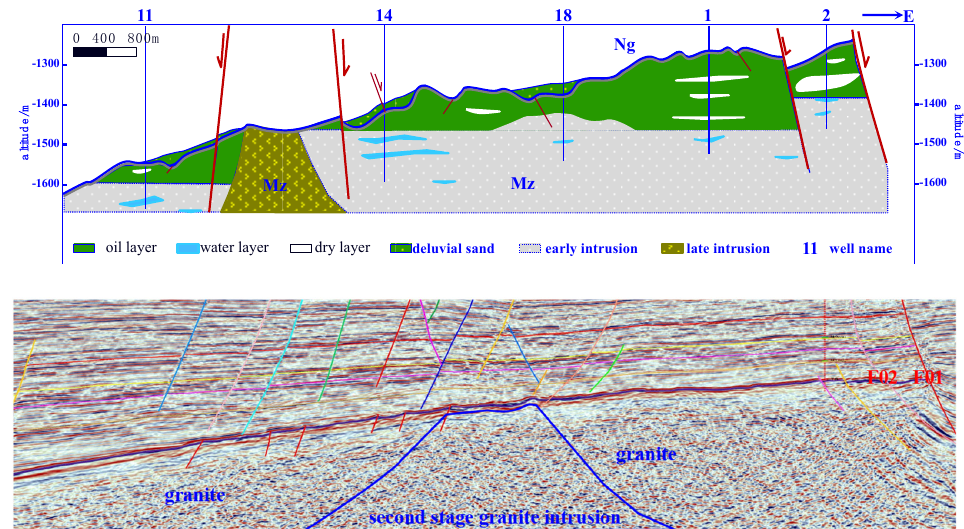
Figure 15. Reservoir model of PL buried-hill. Lithology information was inferred from core, logging, seismic, and geological models, and fluid (oil and water) information was comprehensively analyzed through logging and testing data. On the seismic profile, the reflection characteristics of fault F01 and F02 are relatively clear, but the characteristics of intrusion are fuzzy.